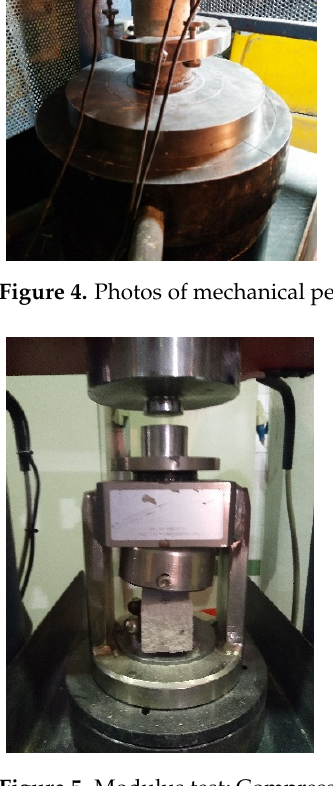
Figure 5. Modulus test; Compression test.